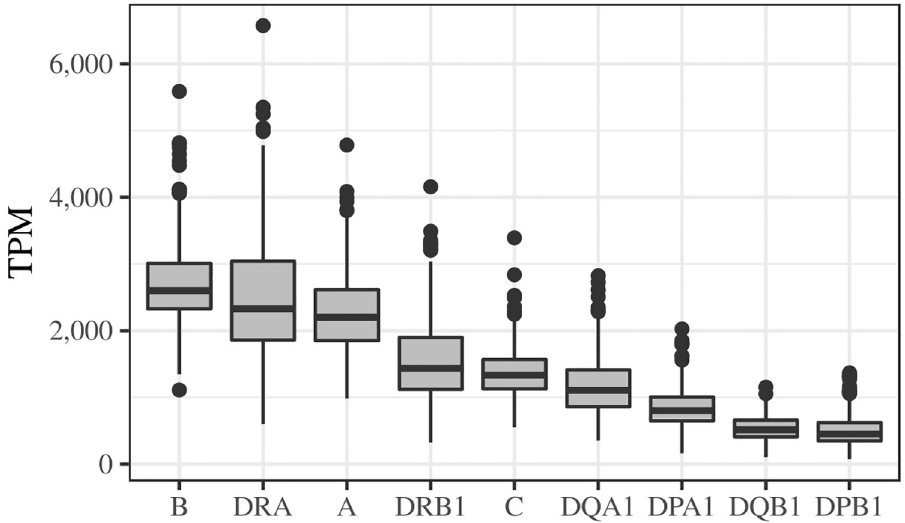
Fig 3. Gene-level expression of classical HLA genes in 358 European individuals from GEUVADIS [24]. Expression was estimated with the HLApers pipeline. Horizontal lines inside each box represent the median. The lower and upper hinges correspond to the first and third quartiles respectively. The whisker lines extend from the hinges to the largest value no further than ± 1.5 × IQR from the hinge (where IQR is the inter-quartile range, or distance between the first and third quartiles). Data beyond the end of the whiskers (“outliers”) are plotted individually. TPM: Transcripts per Million.